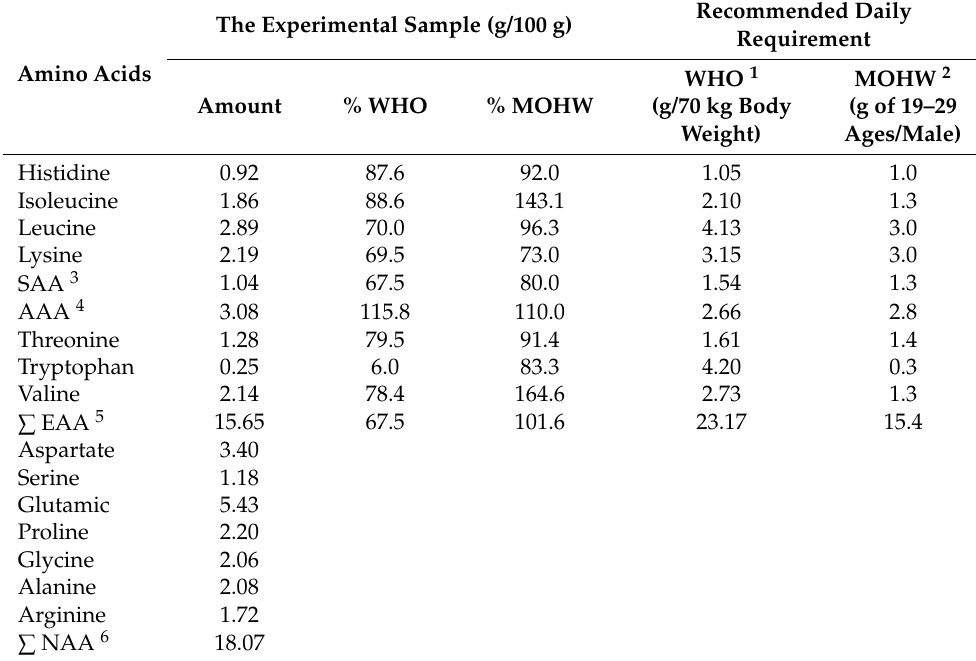
Table 7. The amino-acid composition of the optimal drone pupae